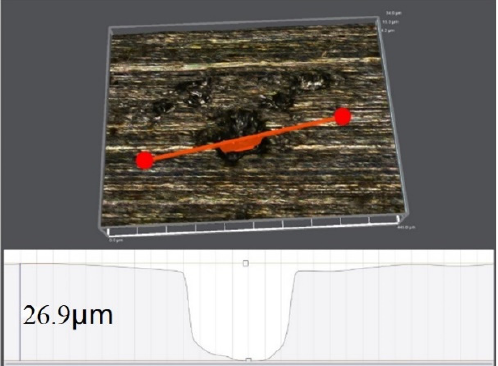
Figure 8. Corrosion pit morphology of common J55 casing after the corrosion simulation test.